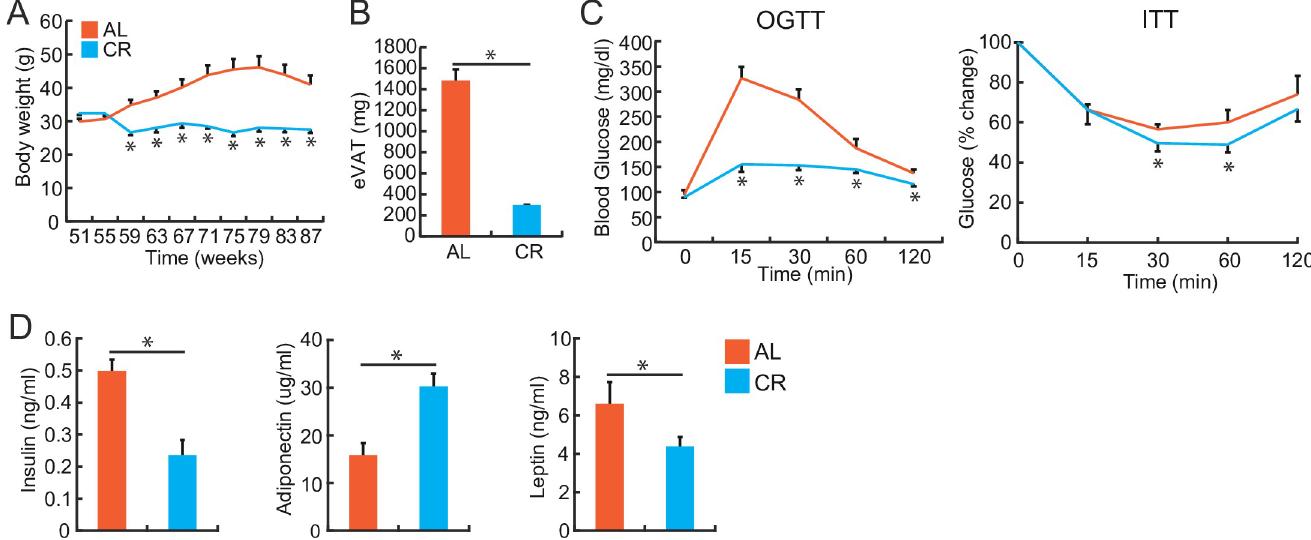
Fig 4. Caloric restriction (CR) improves glucose intolerance and insulin sensitivity during aging. Fifty-two-week-old mice were fed either ad libitum (AL) or treated with caloric restriction (CR) and analyzed on reaching 80 weeks of age. ( A ) Changes in body weight during the time course. ( B ) eVAT weights of the AL and CR mice. ( C ) Results of OGTT and ITT in WT mice fed AL or CR. (D) Serum levels of insulin, adiponectin, and leptin in the AL and CR mice. � P < 0.05. Data are represented as the mean ± SEM.